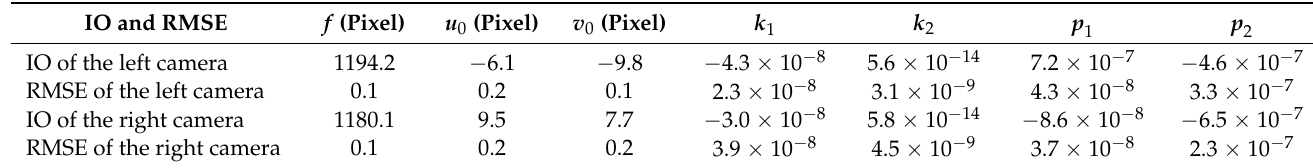
Table 7. In-orbit calibration results of the navigation